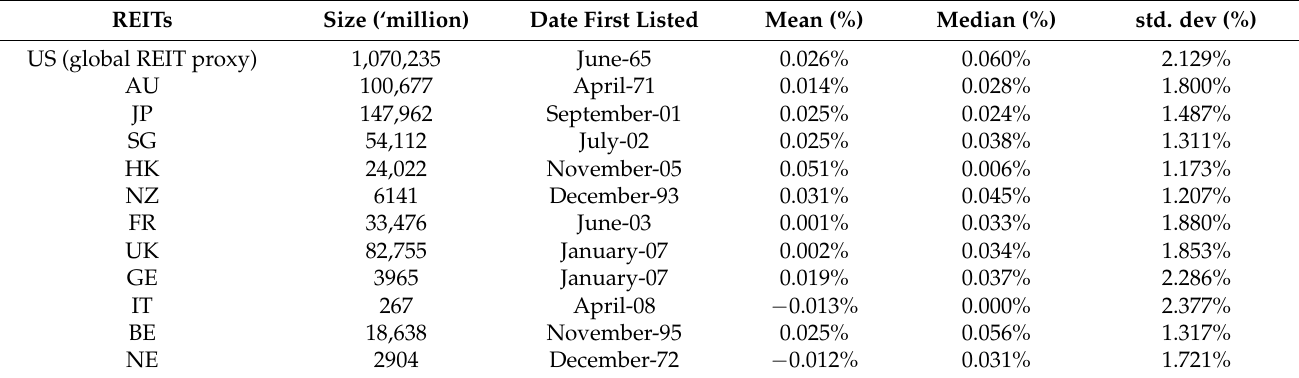
Table 1. Summary of the REIT daily sample: 1 June 2008–30 April